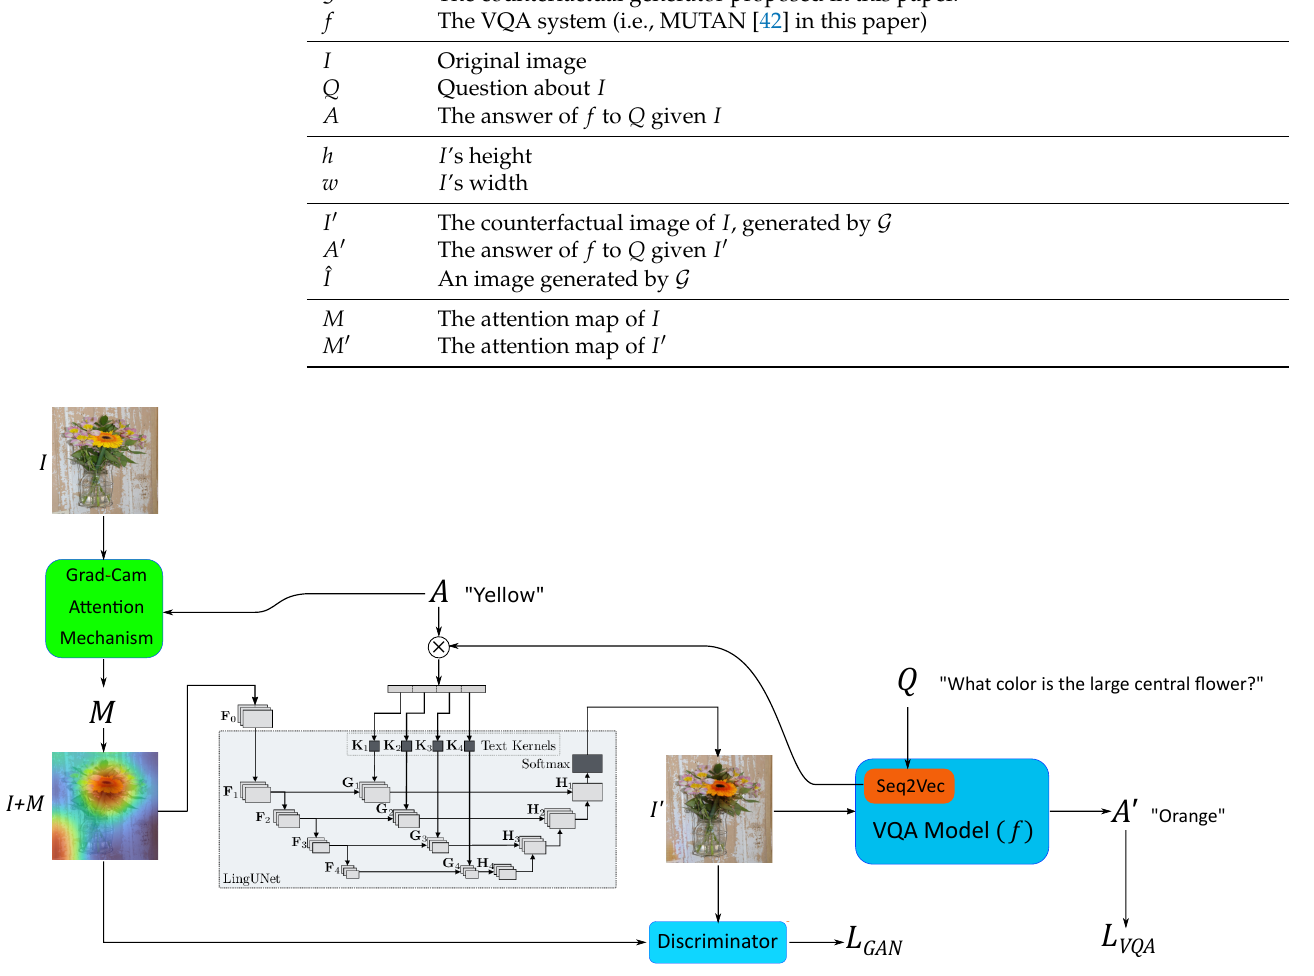
Figure 1. Overview of the proposed architecture inspired by Pan et al.